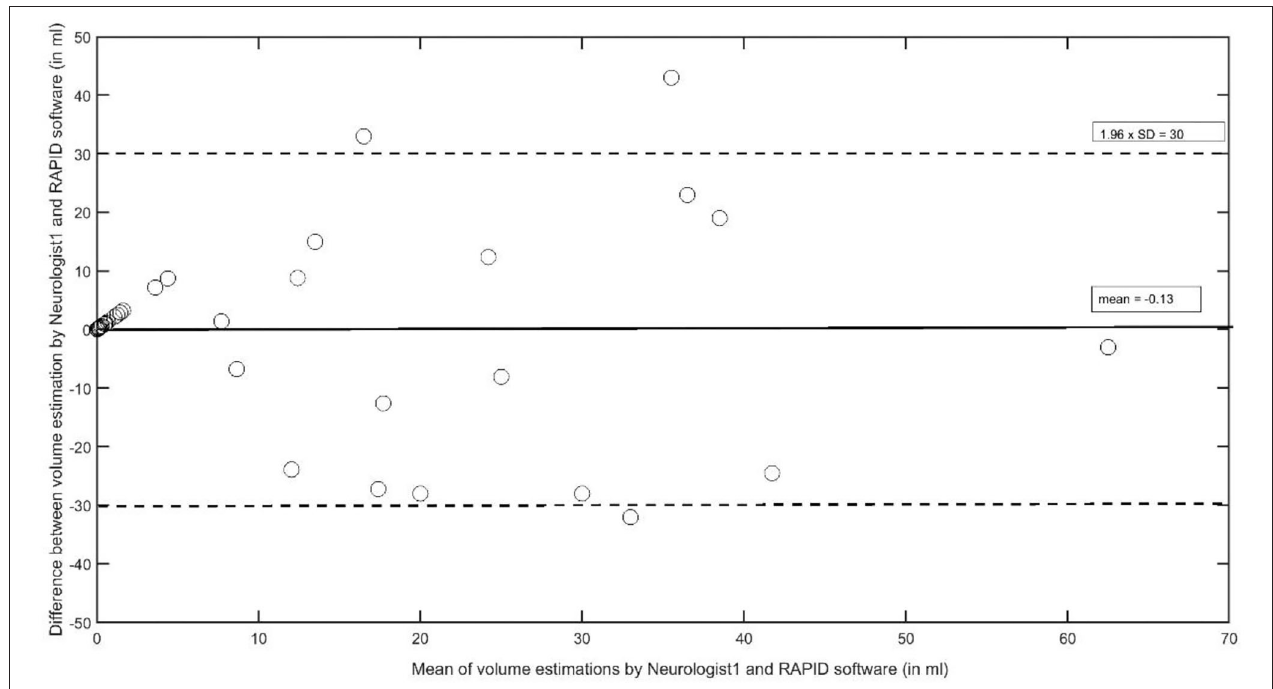
FIGURE 3 | The Bland–Altman plot to analyze interobserver agreement between Neurologist1 and the RAPID software to estimate stroke volumes in the vertebrobasilar artery system.